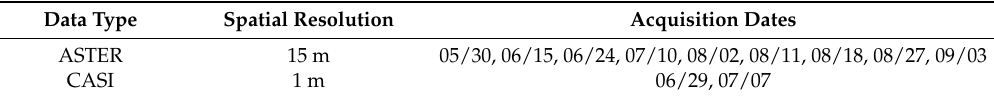
Figure 2. The location and main land types of the study area ( Left: 30-m resolution land cover distributions from the Global Land Cover Product [40]. Right: false color image of the Advanced Spaceborne Thermal Emission and Reflection Radiometer (ASTER) data on 30 May 2012 [37]). Table 1. ASTER and Compact Airborne Imaging Spectrometer (CASI) data used in this study.